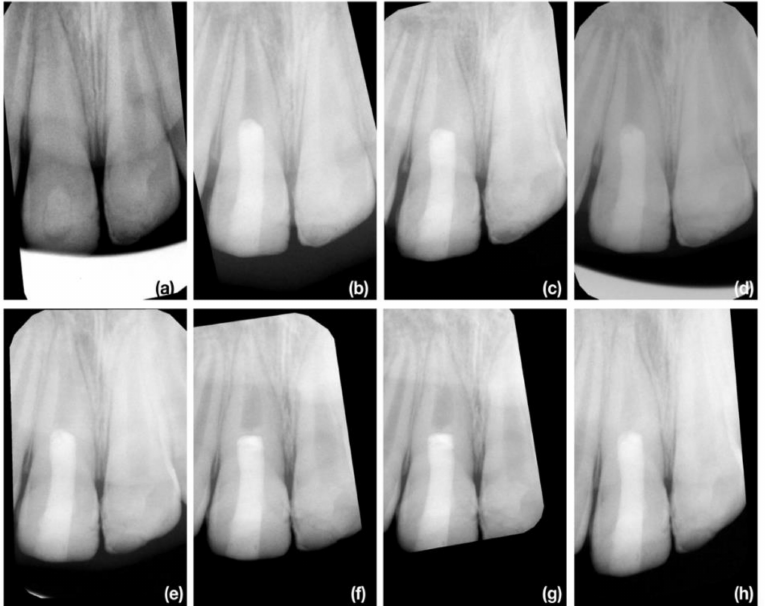
Figure 7. The illustrative case of apical apposition of newly produced mineralized tissue after REP. The 9-year-old boy was referred for endodontic treatment 8 months after dental traumatic injury of tooth 11 (non-complicated crown fracture). ( a ) The diagnostic X-ray of tooth 11 and 21. There is presence of periapical radiolucency of tooth 11; ( b ) The X-ray taken immediately after finishing REP; ( c ) The control X-ray at 3-months follow up. The periapical lesion of tooth 11 was healed; ( d ) The control X-ray at 6-months follow up. No definite signs of any apposition of newly produced mineralized tissue; ( e ) The control X-ray at 9-months follow up. The apposition of newly produced tissue is visible in apical part and in the contact with coronal barrier; ( f ) The control X-ray at 12-months follow up. Radiopaque barrier is more evident in contact with coronal barrier; ( g ) The control X-ray at 18-months follow up. Further apposition of mineralized tissue in apical third of root; ( h ) The control X-ray at 24-months follow up. Progressive production of mineralized tissue in apical third of root is evident and pulp canal obliteration is formed